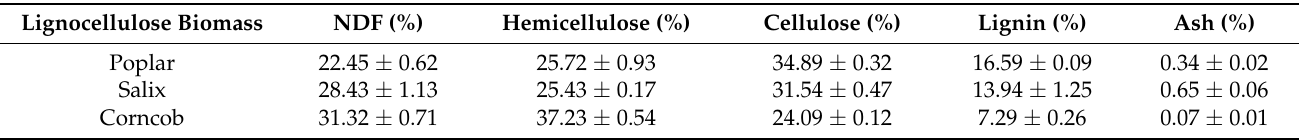
(Table 1) based on Van Soest. All reagents and chemicals are analytical grade. Table 1. Compositions of lignocellulosic biomass. Lignocellulose Biomass NDF